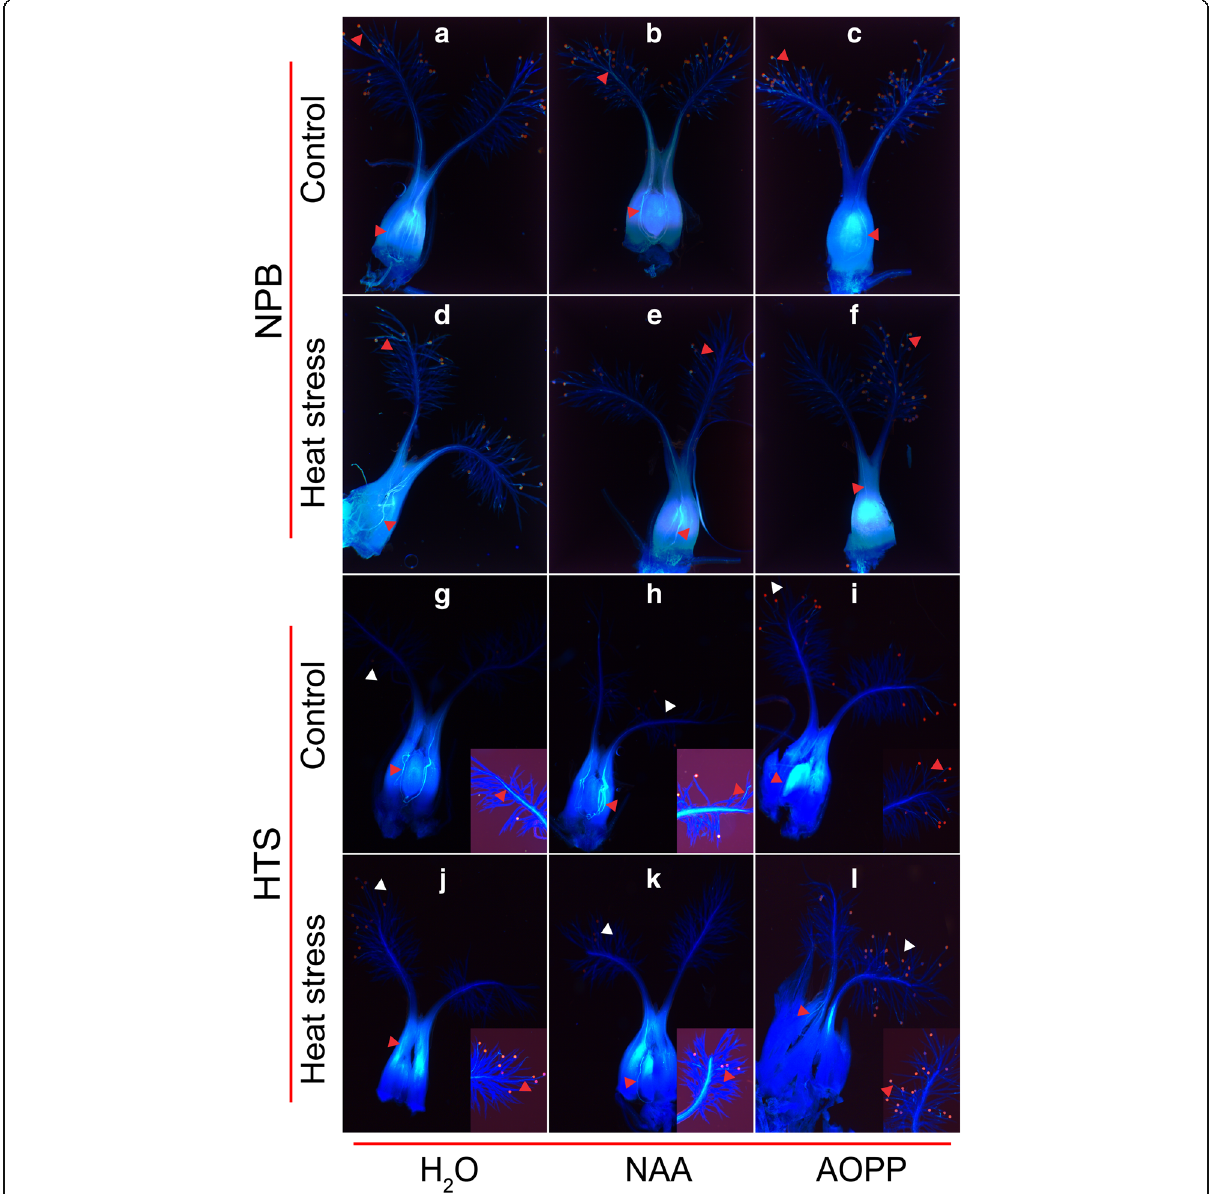
Fig. 3 The pollen germination on stigma and pollen tube elongation in rice pistil under heat stress. The fluorescent images displayed in a - c and d - f show the NPB pistil with pollen tube under natural and heat-stress conditions, respectively; the fluorescent images displayed in g - i and j - l show the HTS pistil with pollen tube under natural and heat stress conditions, respectively. The triangular marks in red indicated the pollen tube; the triangular marks in white indicated the amplifying section in the bottom right of each